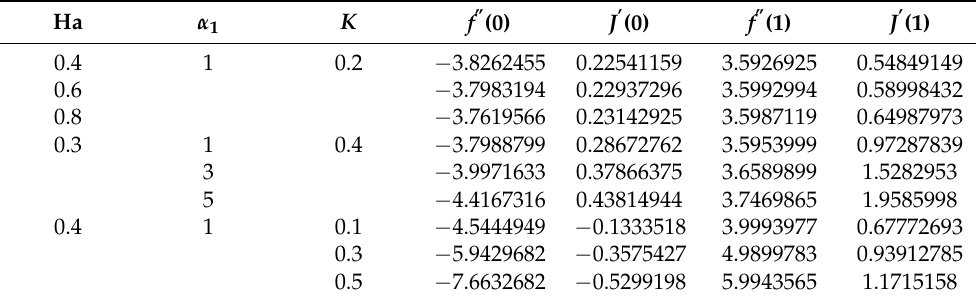
Table 2. Numerical values for Friction Drag Coefficient at both walls.